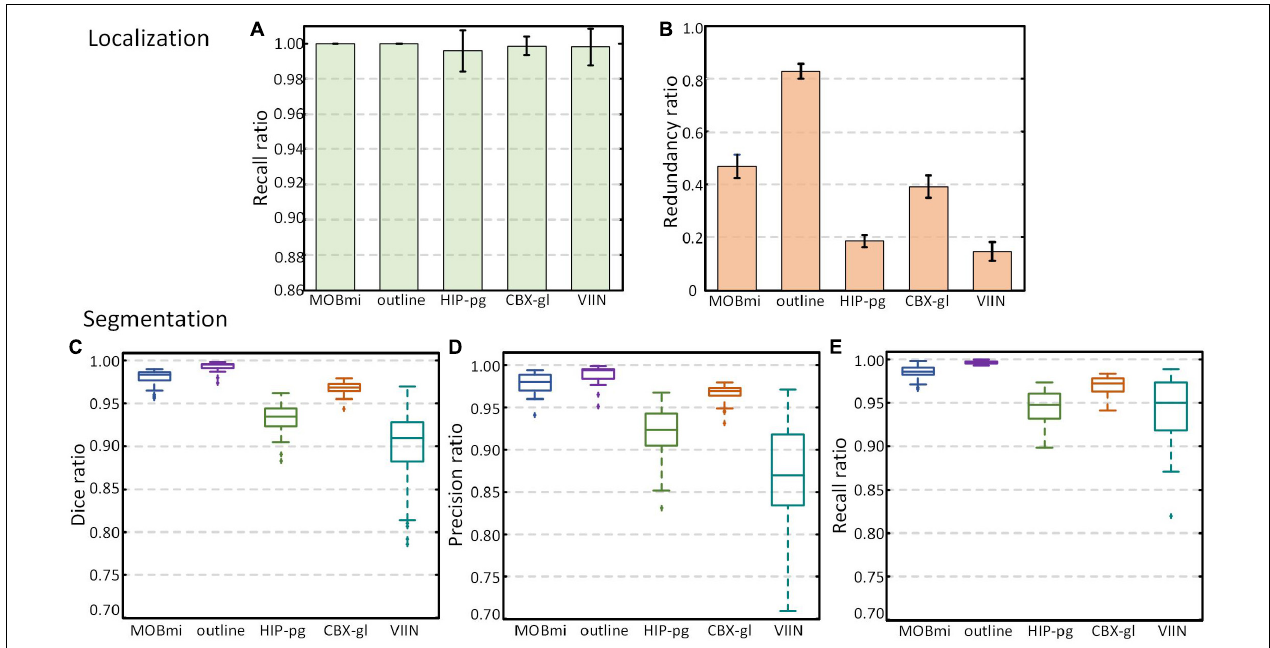
FIGURE 6 | Performance of DeepBrainSeg for brain-wide regions. (A,B) Recall and Redundancy of localization effect. (C–E) Box plots showing Dice, Precision, and Recall (from left to right) of segmentation effect. TABLE 2 | Performance of DeepBrainSeg for brain-wide regions. MOBmi Outline HIP CB